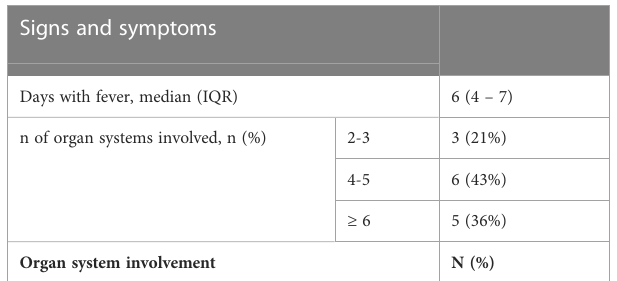
TABLE 1 Detailed clinical and laboratory data of MIS-C patients in the acute phase